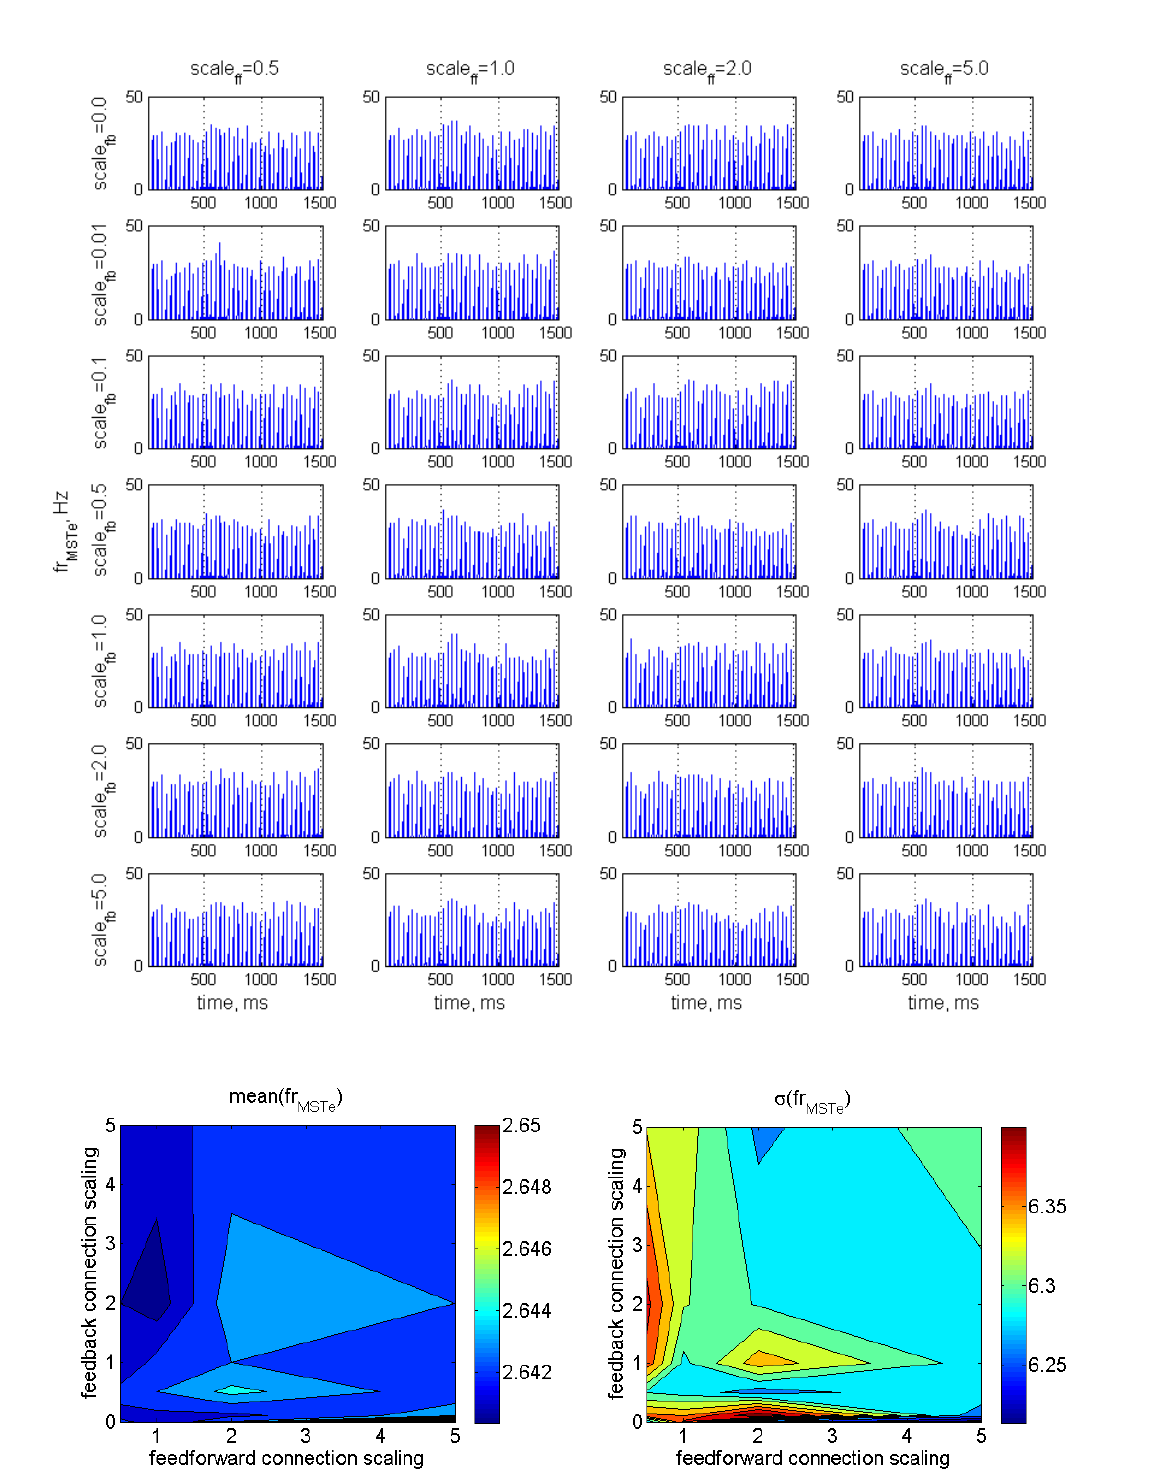
Fig. 6. Spiking activity in MSTe and its mean (bottom left) and variance (bottom right).